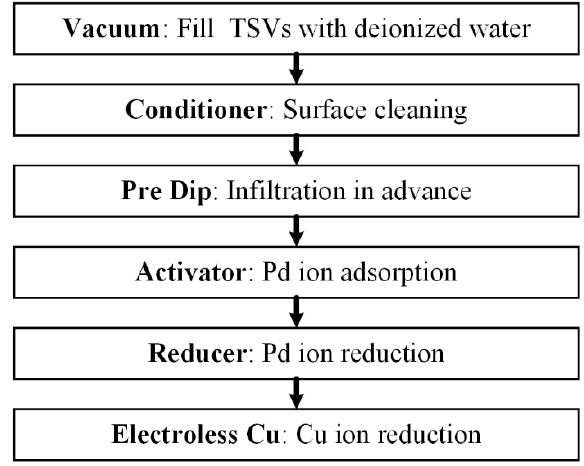
Figure 3. Steps of electroless plating of Cu.